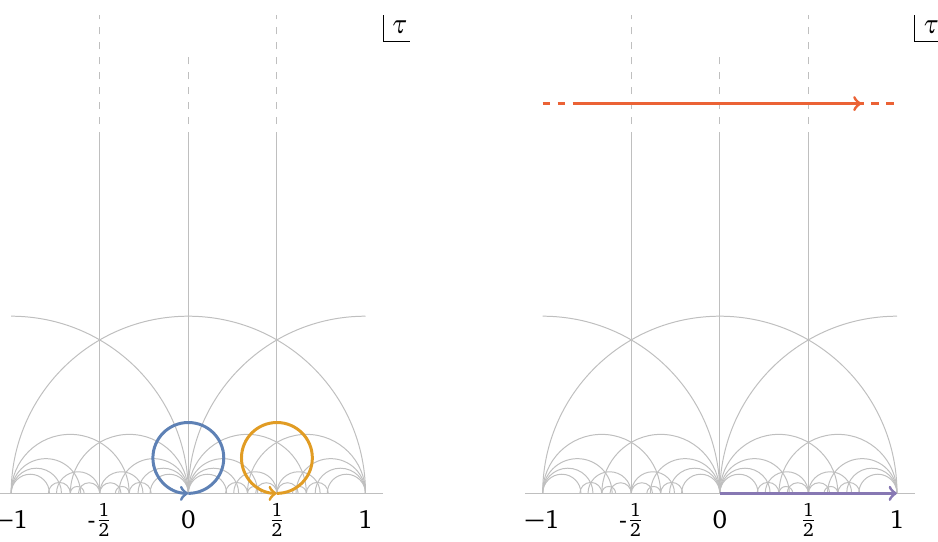
Figure 1: Integration contours in the τ upper half-plane computing unitarity cuts of genus-one amplitudes. Left: Cuts of planar annulus and Möbius strip topologies come from the blue and orange circles starting and ending at τ = 0 and τ = 1 2 respectively. Their radii are irrelevant, but they cannot be shrunken to points because of essential singularities on the real axis. Similar contours exist for the non-planar annulus topology. Right: Cuts of the closed string come from the integration of the + τ = Re τ runs along analytically-continued modular parameter τ = τ , where τ x y x = i Im τ along the red contour parallel to the the purple contour from 0 to 1, and τ y real axis. The vertical displacement of this contour does not